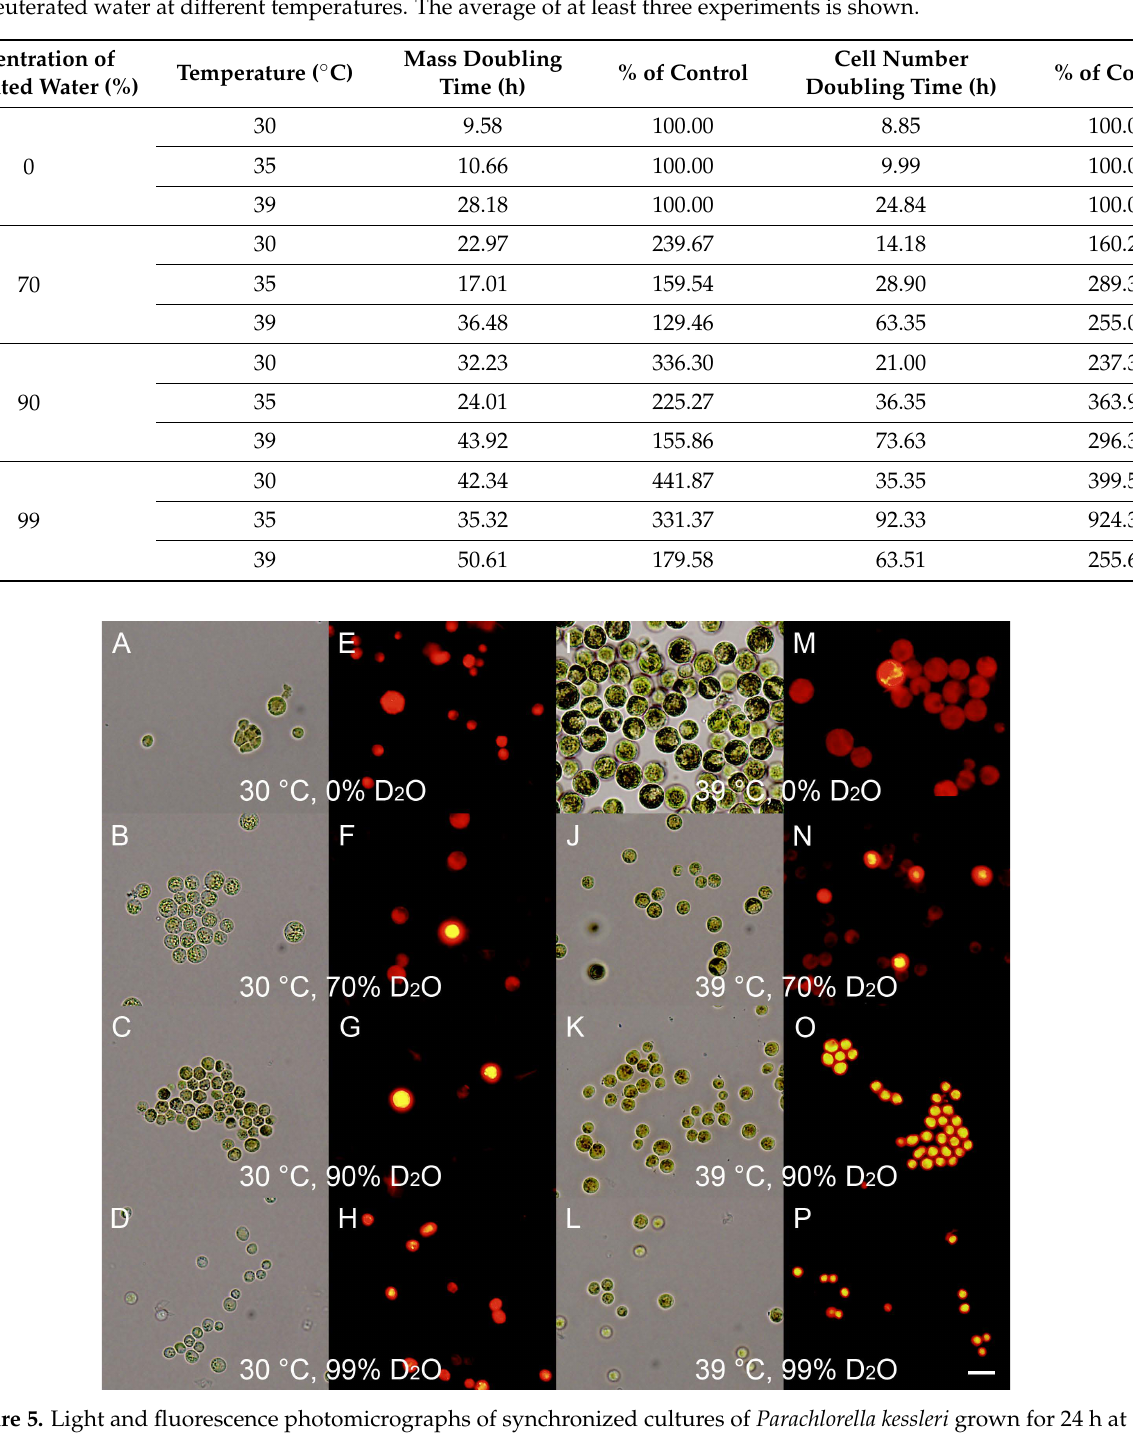
Figure 5. Light and fluorescence photomicrographs of synchronized cultures of Parachlorella kessleri grown for 24 h at an incident light intensity of 110 µ mol photons m − 2 s − 1 , temperatures of 30 ◦ C and 39 ◦ C, and different concentrations of deuterated water in the media (0, 70, 90, and 99%). ( A , E , I , M ) control cultures grown in 0% D 2 O, ( B , F , J , N ) cultures grown in 70% D 2 O, ( C , G , K , O ) cultures grown in 90% D 2 O, and ( D , H , L , P ) cultures grown in 99% D 2 O. In ( A – D ) and ( I – L ) the cells were stained with Lugol’s solution to visualize starch; for ( E – H ) and ( M – P ) the cells were stained with Nile red to visualize neutral lipids. Scale is 10 µ